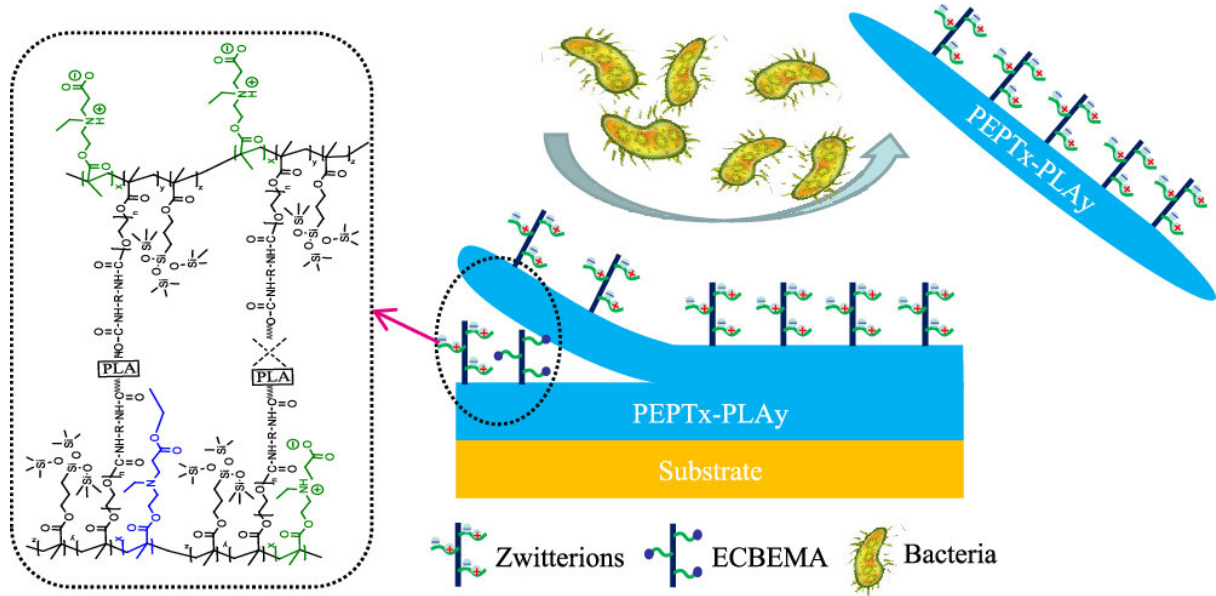
Figure 11. Long-term antifouling PCB-ester-PU with degradable IPDI-PLA-IPDI crosslinker. Repro- duced with permission from [101] . Copyright 2020, American Chemical Society.